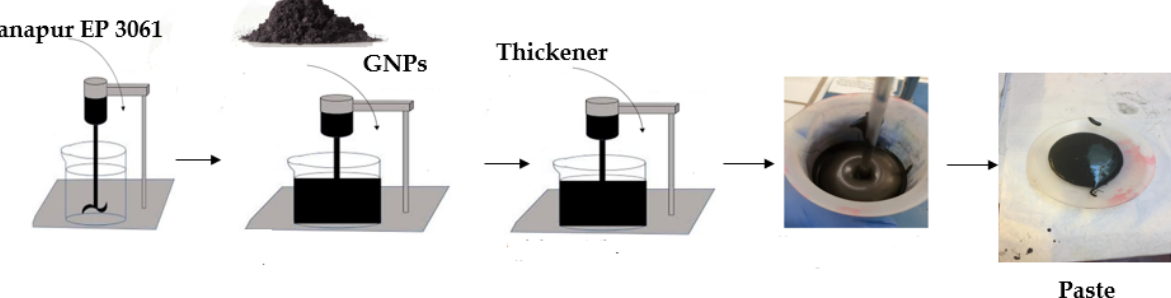
Figure 1. Schematic representation of the preparation of paste with polymer and carbon-based